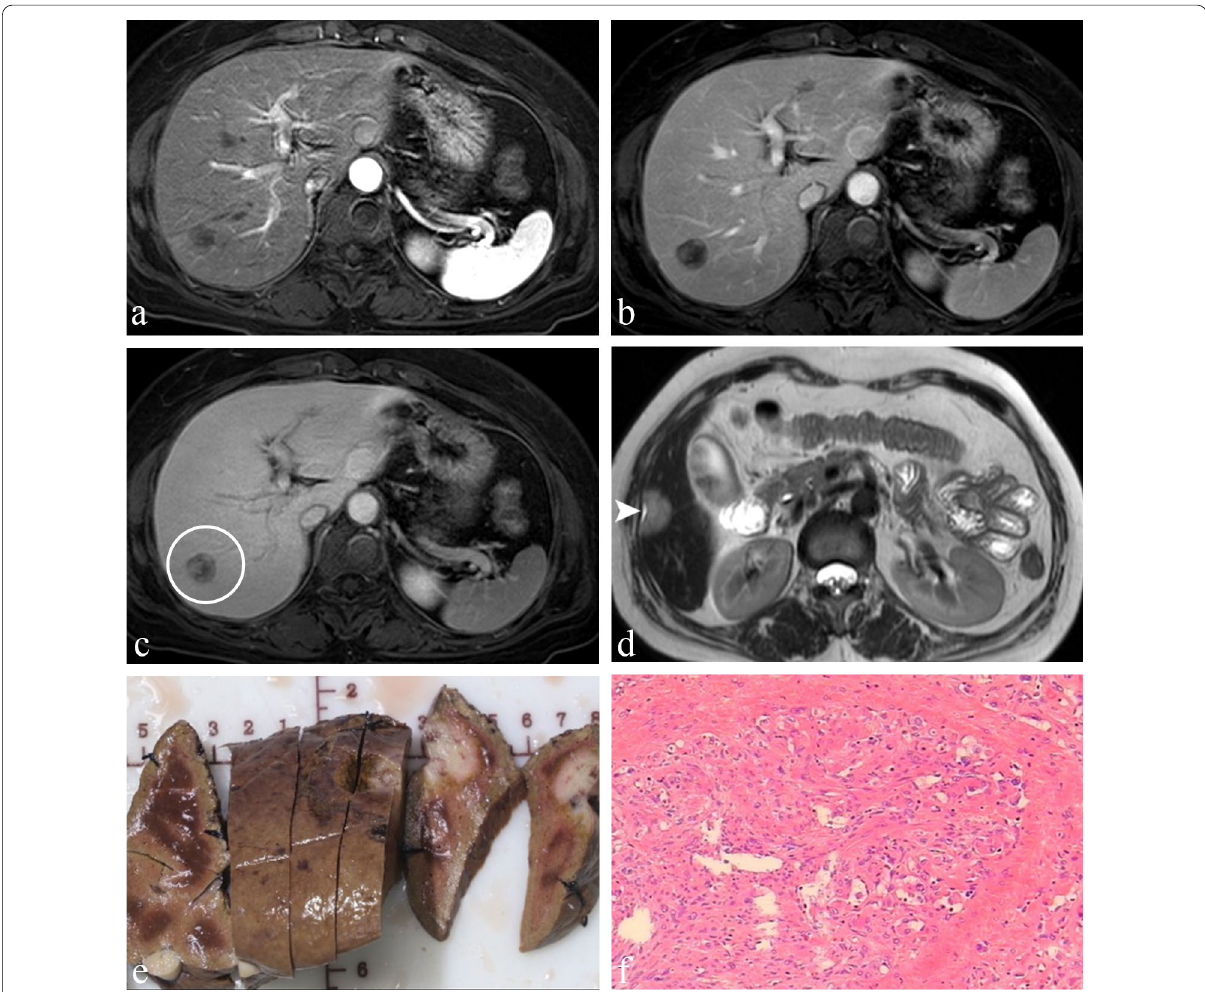
Fig. 4 A 53-year-old woman was diagnosed with HEHE on both imaging and pathology. a – c On axial contrast-enhanced MRI, the tumour in segment 6 of the liver represents a centripetal progressive filling with a decrease in signal intensity and finally shows a targetoid appearance on the equilibrium phase ( arrow, c ). There was another lesion with hepatic capsular retraction ( arrowhead ) on axial T2WI ( d ). e Gross solid specimen after surgery shows multifocal lesions located in the periphery of the liver. f Hematoxylin–eosin stain reveals that tumours are mainly composed of eosinophilic epithelioid cells arranged in sheet-like